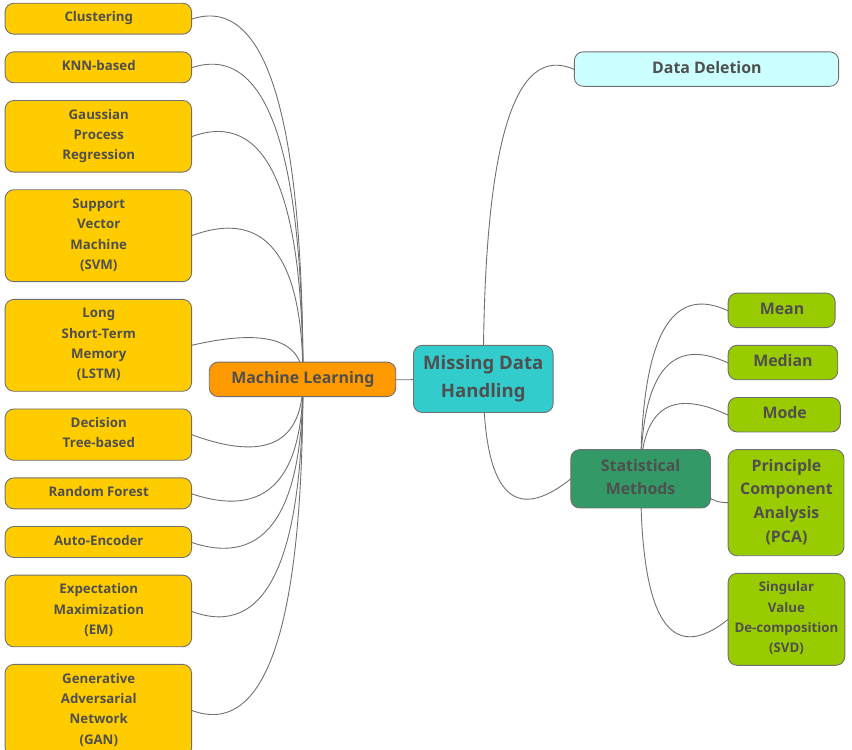
Figure 1. The categorization of traditional and machine learning based algorithms used for missing data